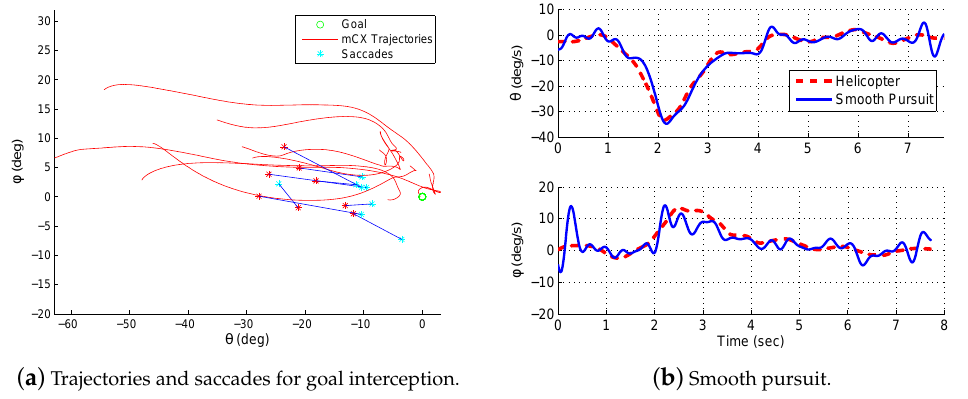
Figure 15. Step task results: ( a ) Saccades during step experiments (multiple trials), and ( b ) gaze pursuit mode and rotorcraft velocities in the head